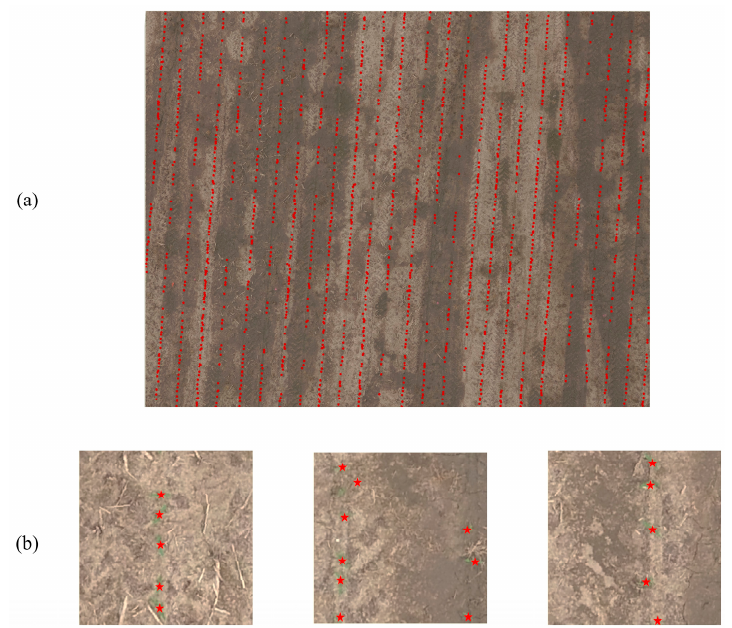
Figure 11. ( a ) Detected plants in the second image: ( b ) Instances of the extracted image patches. Red stars are the centers of predicted plants according to the object detector.